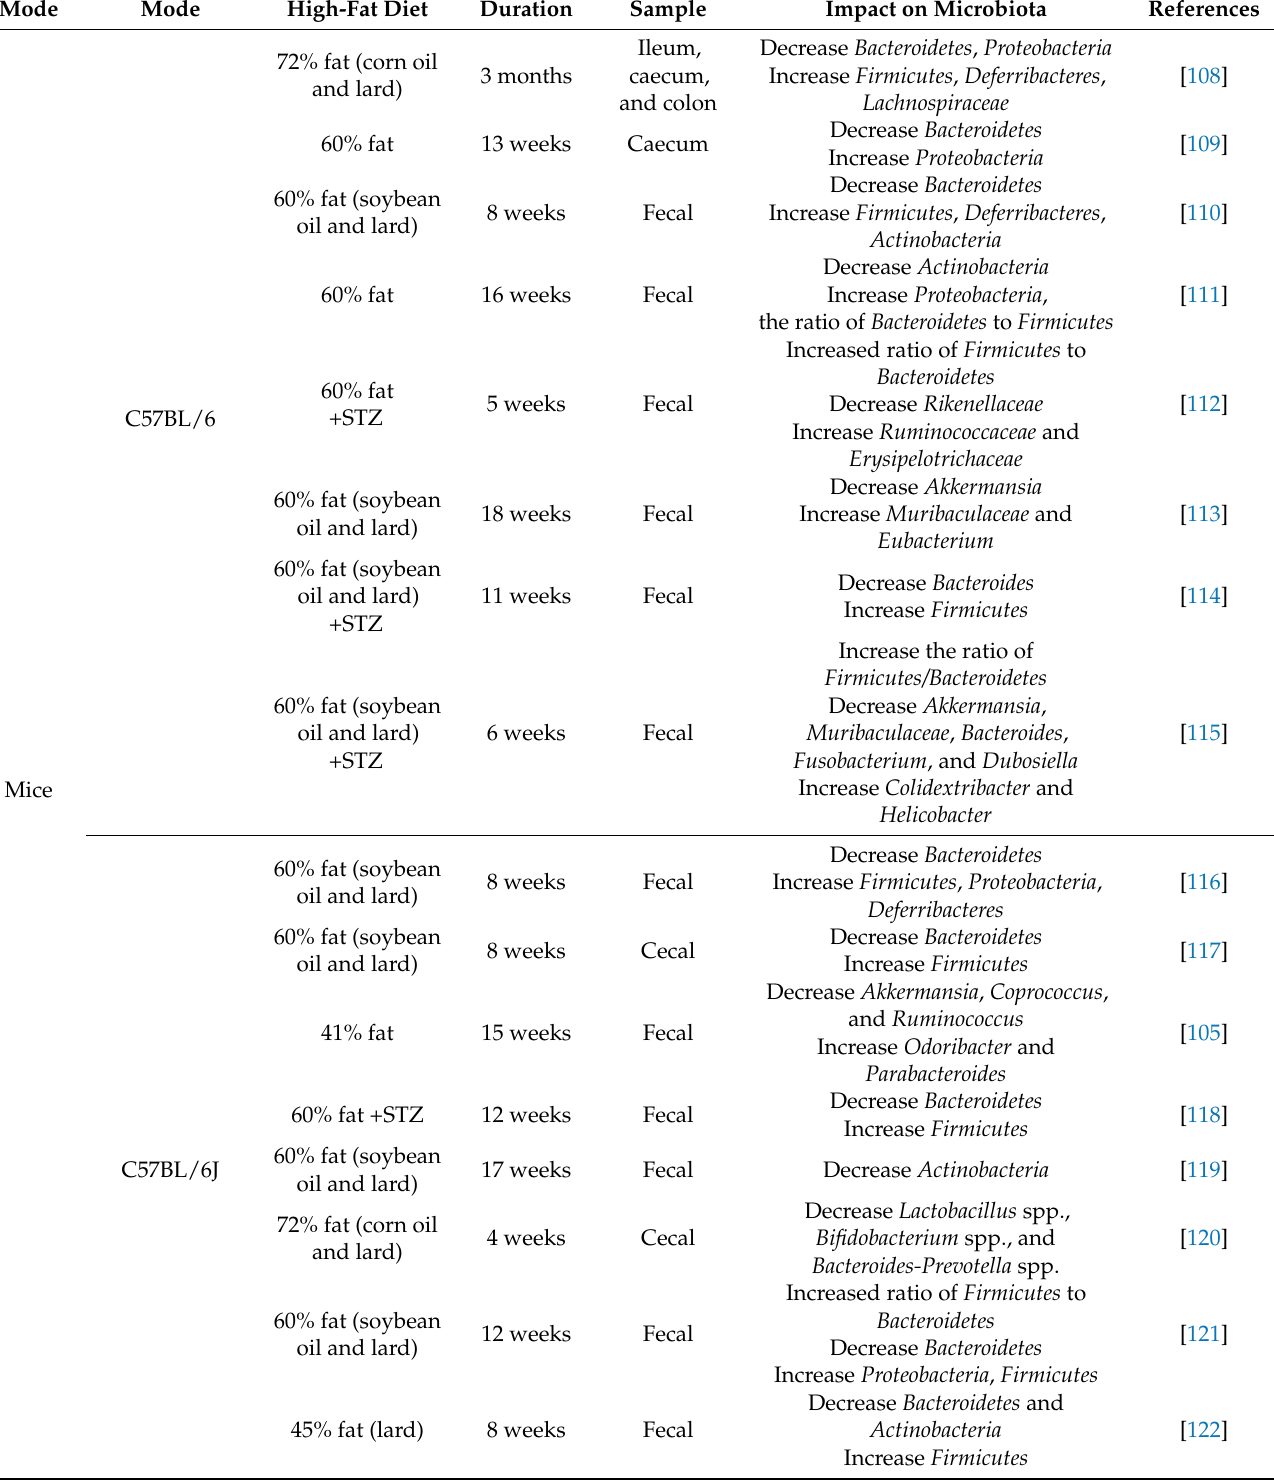
Table 3. Effect of an HFD on gut microbes in diabetic animal